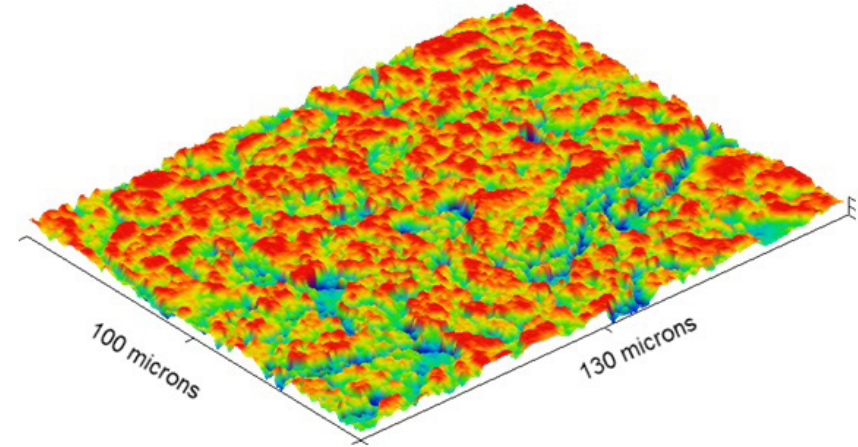
Figure 8. AFM image of Nitinol composite at sintering temperature 1000 0 C for 30